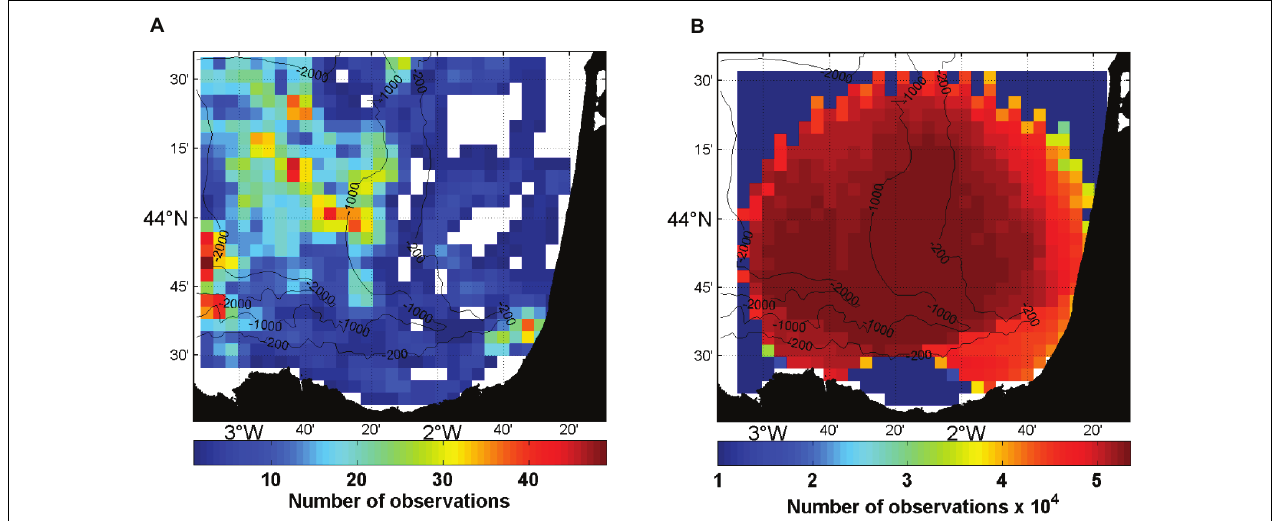
FIGURE 3 | (A) Sum of the number of observations from drifters, Argo-floats drifting at the surface and T/S profiles, used in the MDT computation, within the HF radar currents grid and (B) sum of the number of HF radar observations ( × 10 4 ).